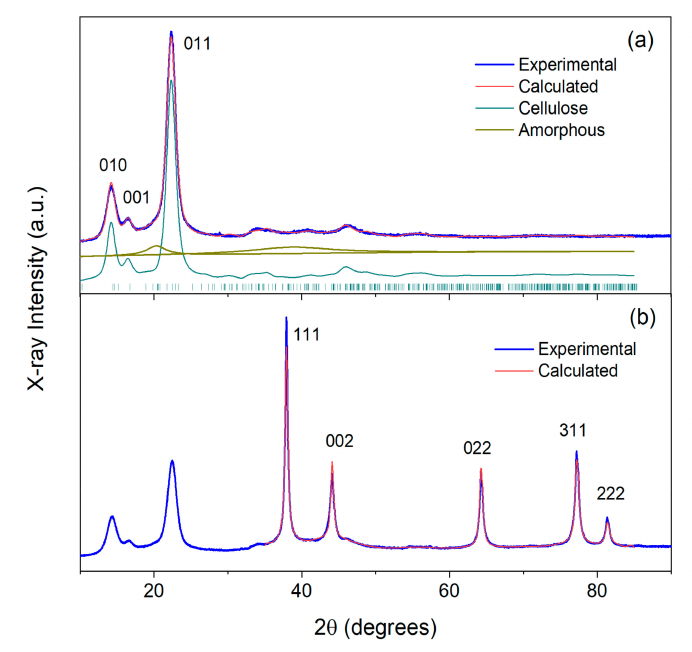
Figure 10. ( a ) X-ray diffraction pattern of initial SBCB ( a ) and composite Ag NPs/SBCB ( b ) and their fits. The main cellulose reflections and reflections of Ag metal are designated by figures.